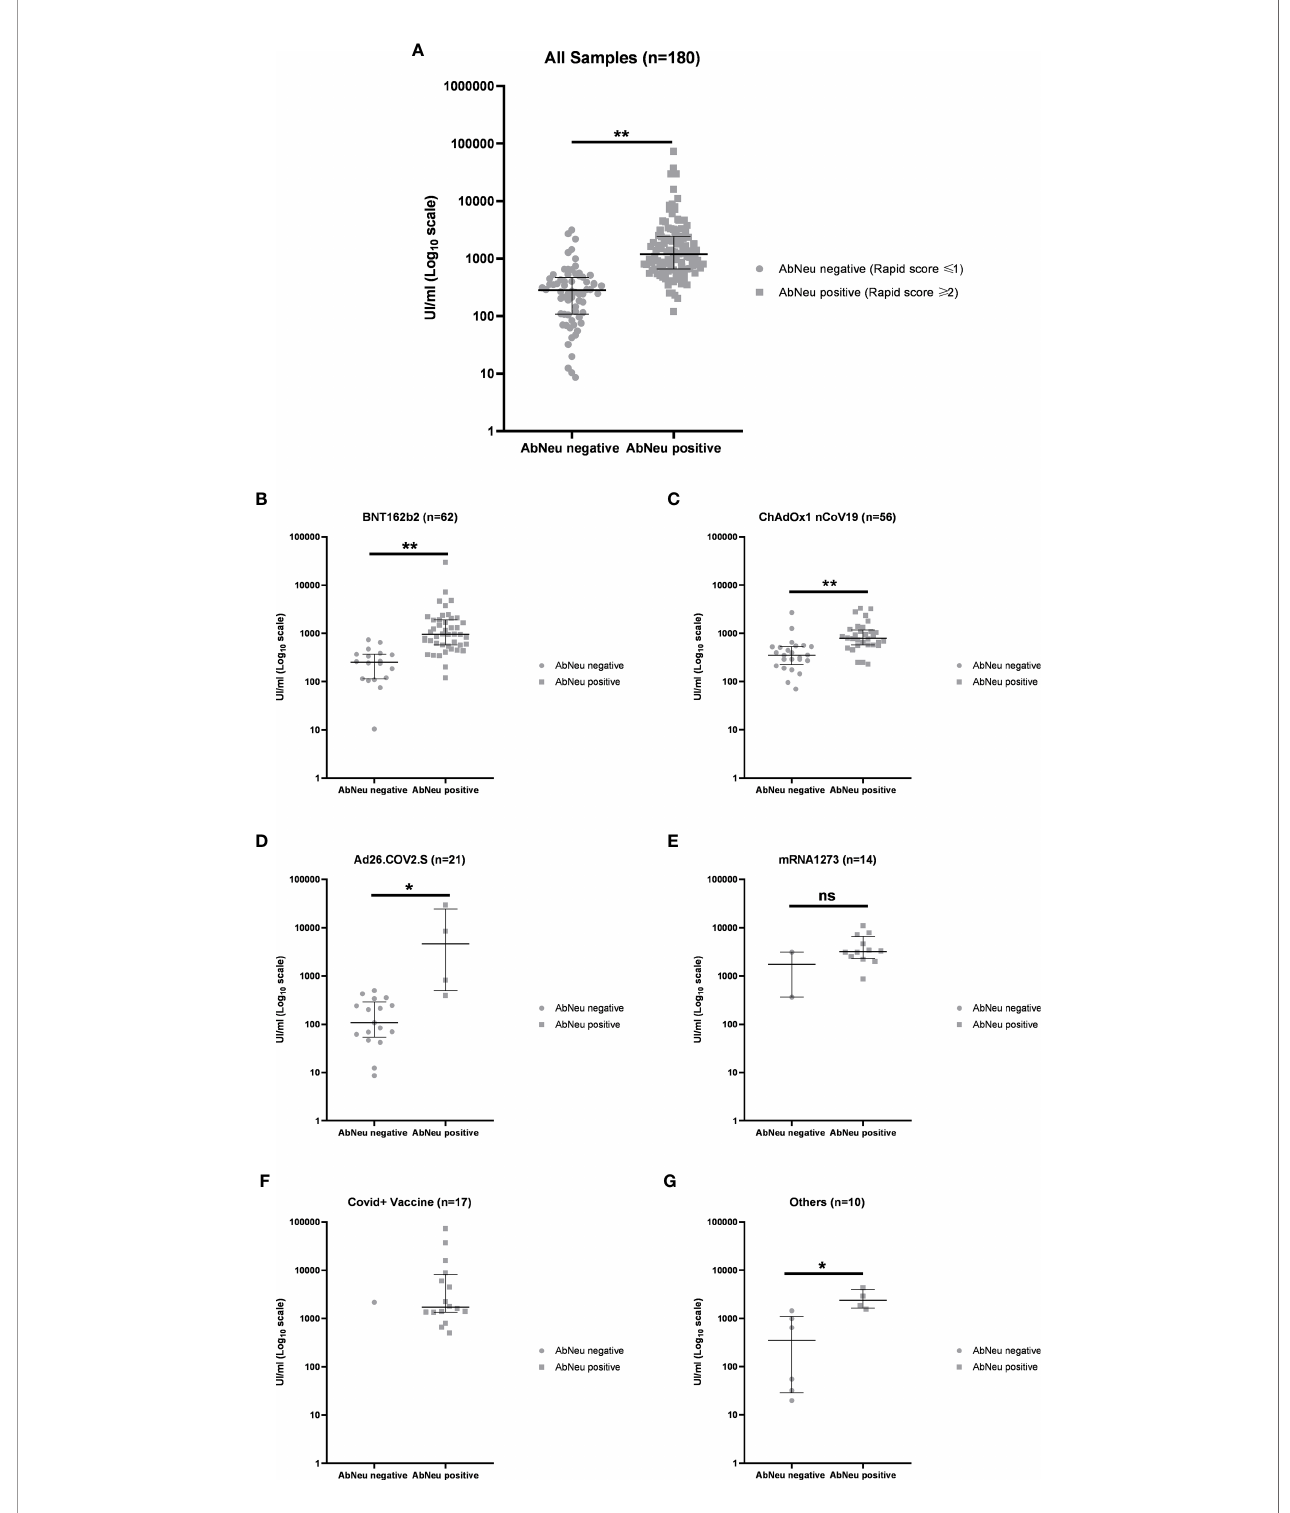
FIGURE 5 | (A) Distribution of anti-receptor-binding domain (anti-RBD) antibody titers in AbNeu-positive and AbNeu-negative sera from 180 participants in the study and within each vaccination group: (B) BNT162b2, (C) ChAdOx1 nCov19, (D) Ad26.COV2.S, (E) mRNA-1273, (F) COVID19 + vaccine, and (G) others. Data are represented as scatter plot with median UI/ml ± IQR on log10 scale. Mann – Whitney test was performed to assess statistical signi fi cance of differences between medians (see Table 5 ). ** p -value <0.0001; * p -value <0.01; ns, not speci fi